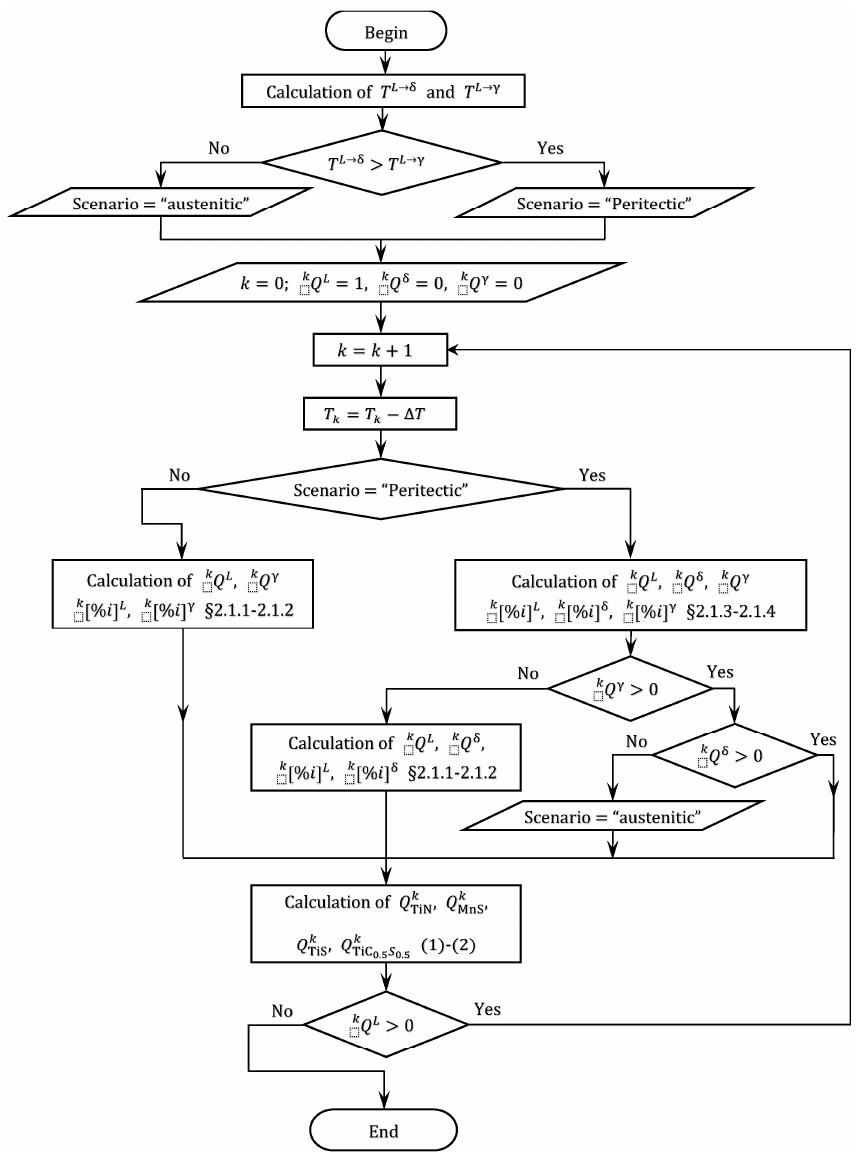
Figure 1. Block diagram of the